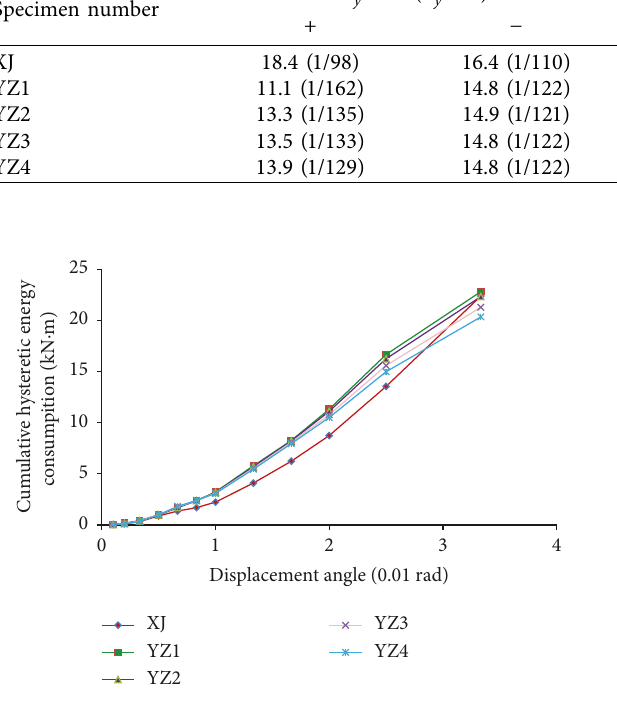
Figure 12: Equivalent viscous damping coefficient